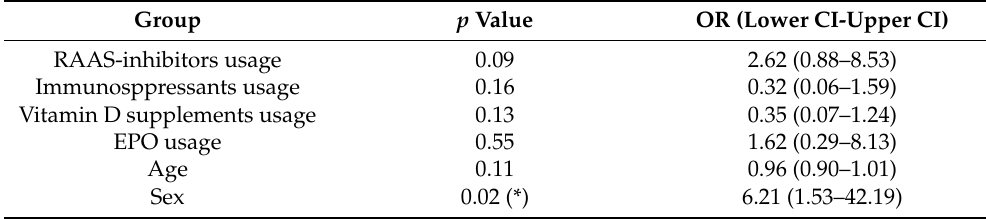
Table 5. Influence of variables on responder status. Group p Value OR (Lower CI-Upper